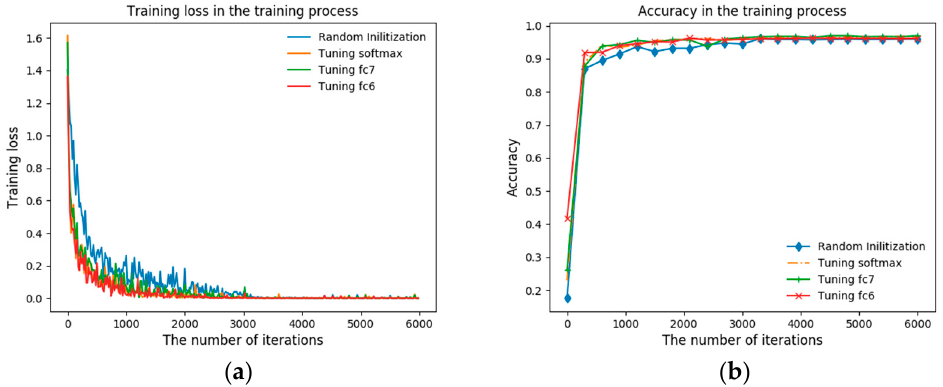
Figure 7. The variation of training loss and testing accuracy in the training process. ( a ) Training loss in the training process. ( b ) Testing accuracy in the training process.